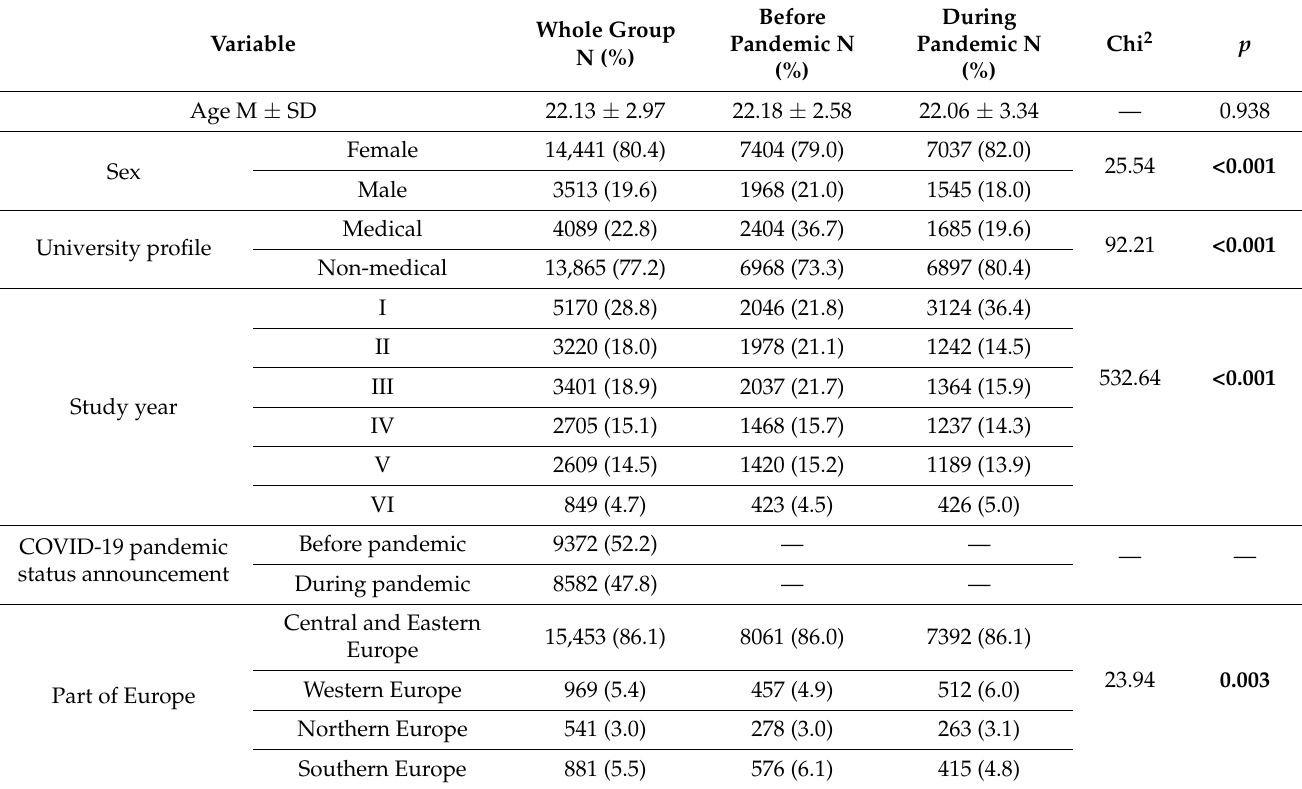
Table 1. Characteristics of the study group and the comparison regarding the COVID-19